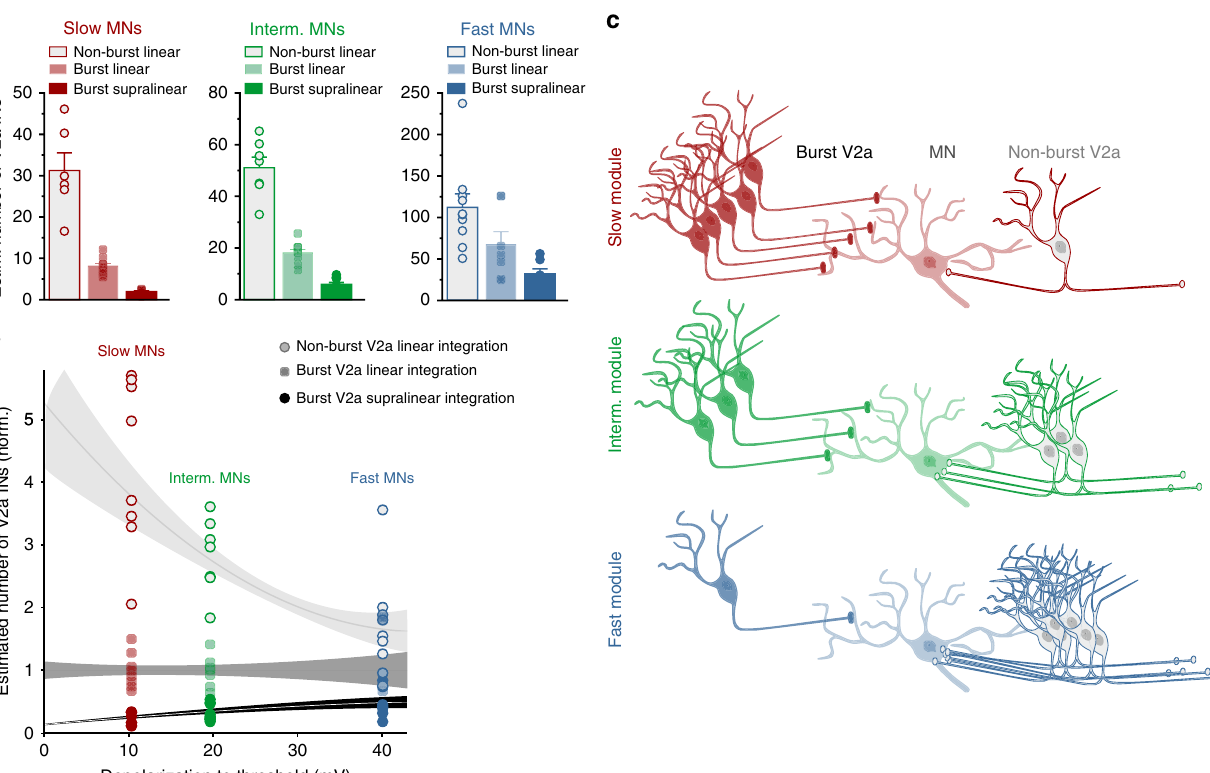
Fig. 7 Module-speci fi c convergence pattern of bursting- and non-bursting-type V2a interneurons. a The estimated number of converging V2a interneurons required to recruit slow, intermediate or fast motoneurons. For the bursting-type V2a interneuron this was calculated based either on supra-linear (non- linear) or linear summation. For non-bursting, this estimation was based only on linear integration. The data represent means and error bars re fl ect s.e.m. b Impact of the synaptic integration modes of bursting- versus non-bursting-type V2a interneurons on the degree of convergence of V2a interneurons required to drive the recruitment of motoneurons in the slow, intermediate and fast modules. The degree of convergence was calculated by